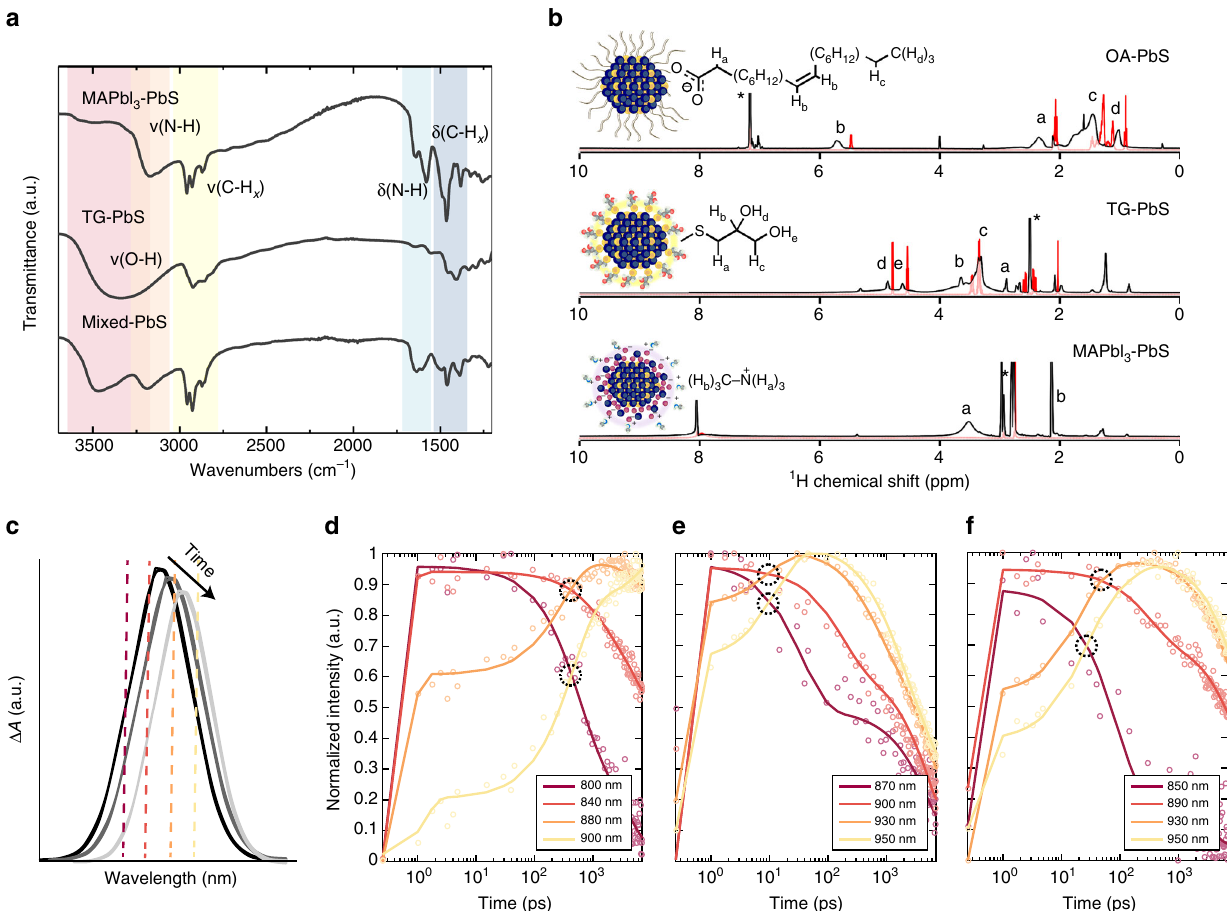
Fig. 2 Characterizations of ligand attachment and transient absorption photophysics. a Fourier transform infrared (FT-IR) spectra of PbS QDs passivated by (i) MAPbI 3 (ii) TG, and (iii) two types of ligands (mixed-QD sample). b 1 H NMR spectra of quantum dot ligands in solution (red) and bound to PbS quantum dot surface (black). (i) Oleic acid and lead oleate-capped QDs in C 6 D 6 benzene. (ii) TG and TG-capped QDs in d 6 -DMSO. (iii) MAI + PbI 2 solution sample and MAI + PbI 2 -capped QDs in d 7 -DMF. For (ii) and (iii), signals between 0 and 2 ppm are from residual oleate bound to the QDs after the ligand exchange. Peaks from trace nondeuterated solvents are marked by asterisks. c Schematic representation of spectral diffusion. Dashed lines indicate the position of time traces for panels d – f relative to the peak maximum of the exciton bleach. d – f TA spectral time traces of bleaching signals for d TG- capped QDs, e MAPbI 3 -capped QDs, and f mixed-QD fi lms. We track spectral diffusion by the point of crossover between the decay of high-energy wavelengths and the rise of lower energy wavelengths, encircled in ef fi cient charge separation at the nanoscale interface. Elementally resolved electron microscopy indicates a uniform mixture of donor and acceptor in the extended QD solid. We fabricate the fi rst mixed-quantum-dot ink solar cells and achieve a solar power conversion of 10.4%, two times as high as the performance of previously reported BHJ QD devices 8 .